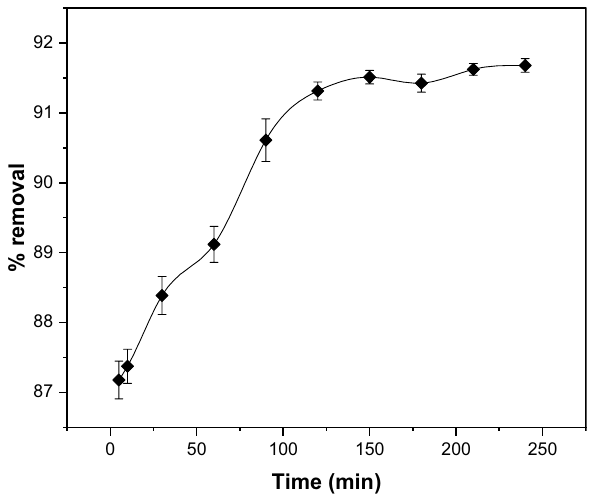
Figure 10. Effect of contact time on adsorptive CR removal using GSC WCO .